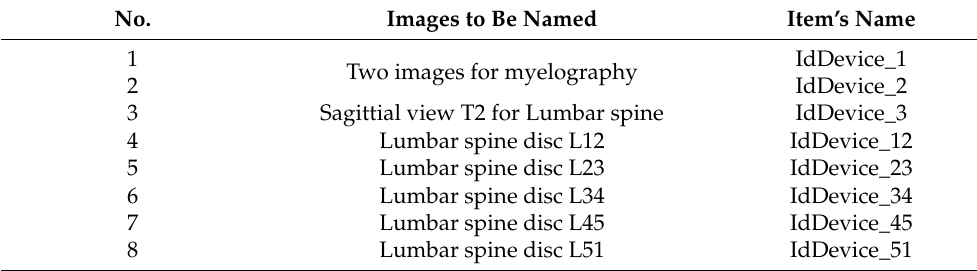
Table 2. The process of naming data taken from the PACS